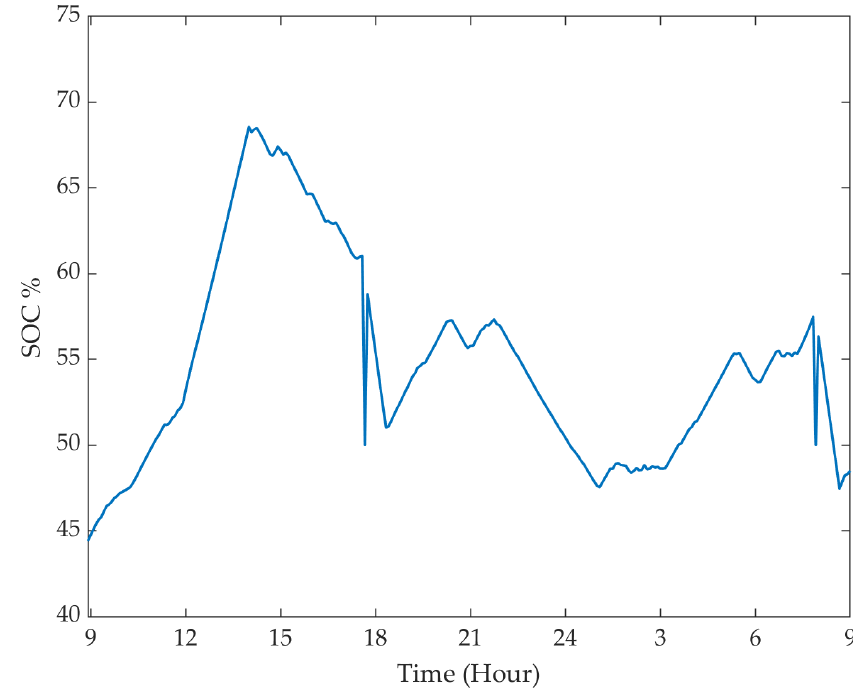
Figure 10. SOC percentage of one EV from 9 a.m. on the first day to 9 a.m. on the second